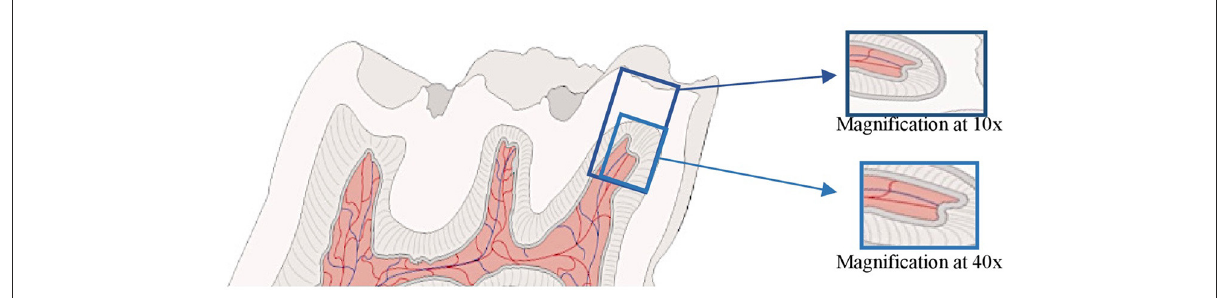
FIGURE1 Illustration of a Wistar rat’s molar analyzed: pulp horn and respective cusp at 10x magnification and pulp horn chamber at 40x